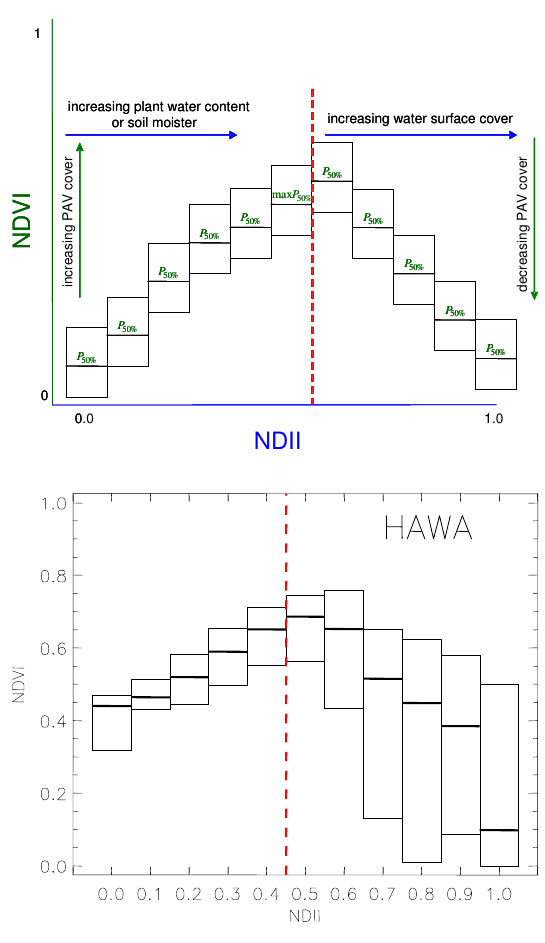
Fig. 7. Schematic representation of NDVI and NDII relations (top) and derivation of NDII threshold for HAWA , tf computing NDVI statistics at 0.1 NDII intervals (bottom).